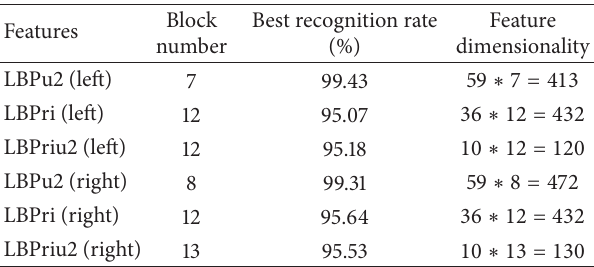
Table 8: Block selection using contribution of block location by looking at the recognition rate of each block